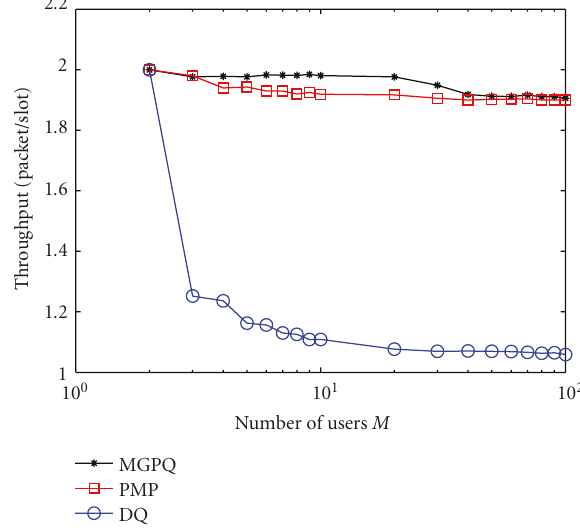
Figure 9: Throughput comparison between MGPQ, PMP, and DQ for di ff erent number of